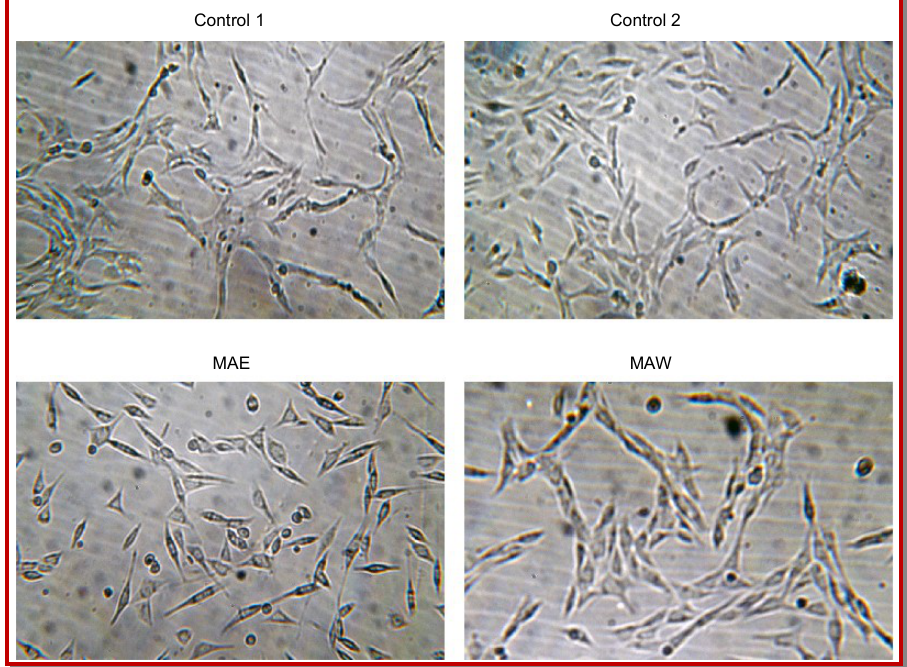
Figure 5: Effects of Mahonia aquifolium water (MAW) and ethanol (MAE) extracts on angiogenesis of endothelial cells. Applied concentrations of MAW and MAE were 80 µg/mL. Representative photomicrographs of one out of two independent experiments are